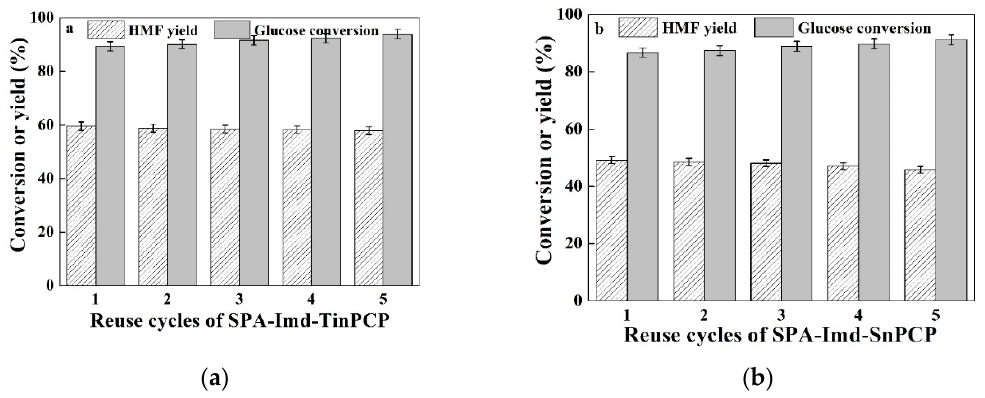
Figure 11. Consecutive use of SPA-Imd-TinPCP for glucose conversion into HMF in ( a ) DMSO; ( b ) H 2 O/THF (1:4). The reaction time was 5 h. The working pressure was 5 atm. Table 2. Comparison of SPA-Imd-TinPCP with other catalysts: HMF yield and selectivity.